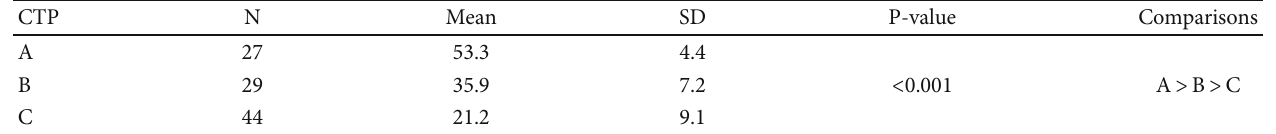
Table 7: Comparison of 25-OHD levels in di ff erent CTP categories.